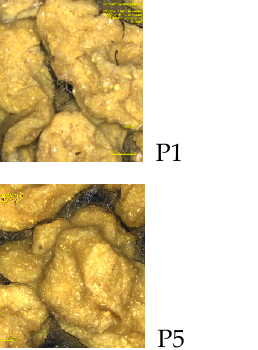
Figure 13. 3D laser microscopy of quercetin microspheres.